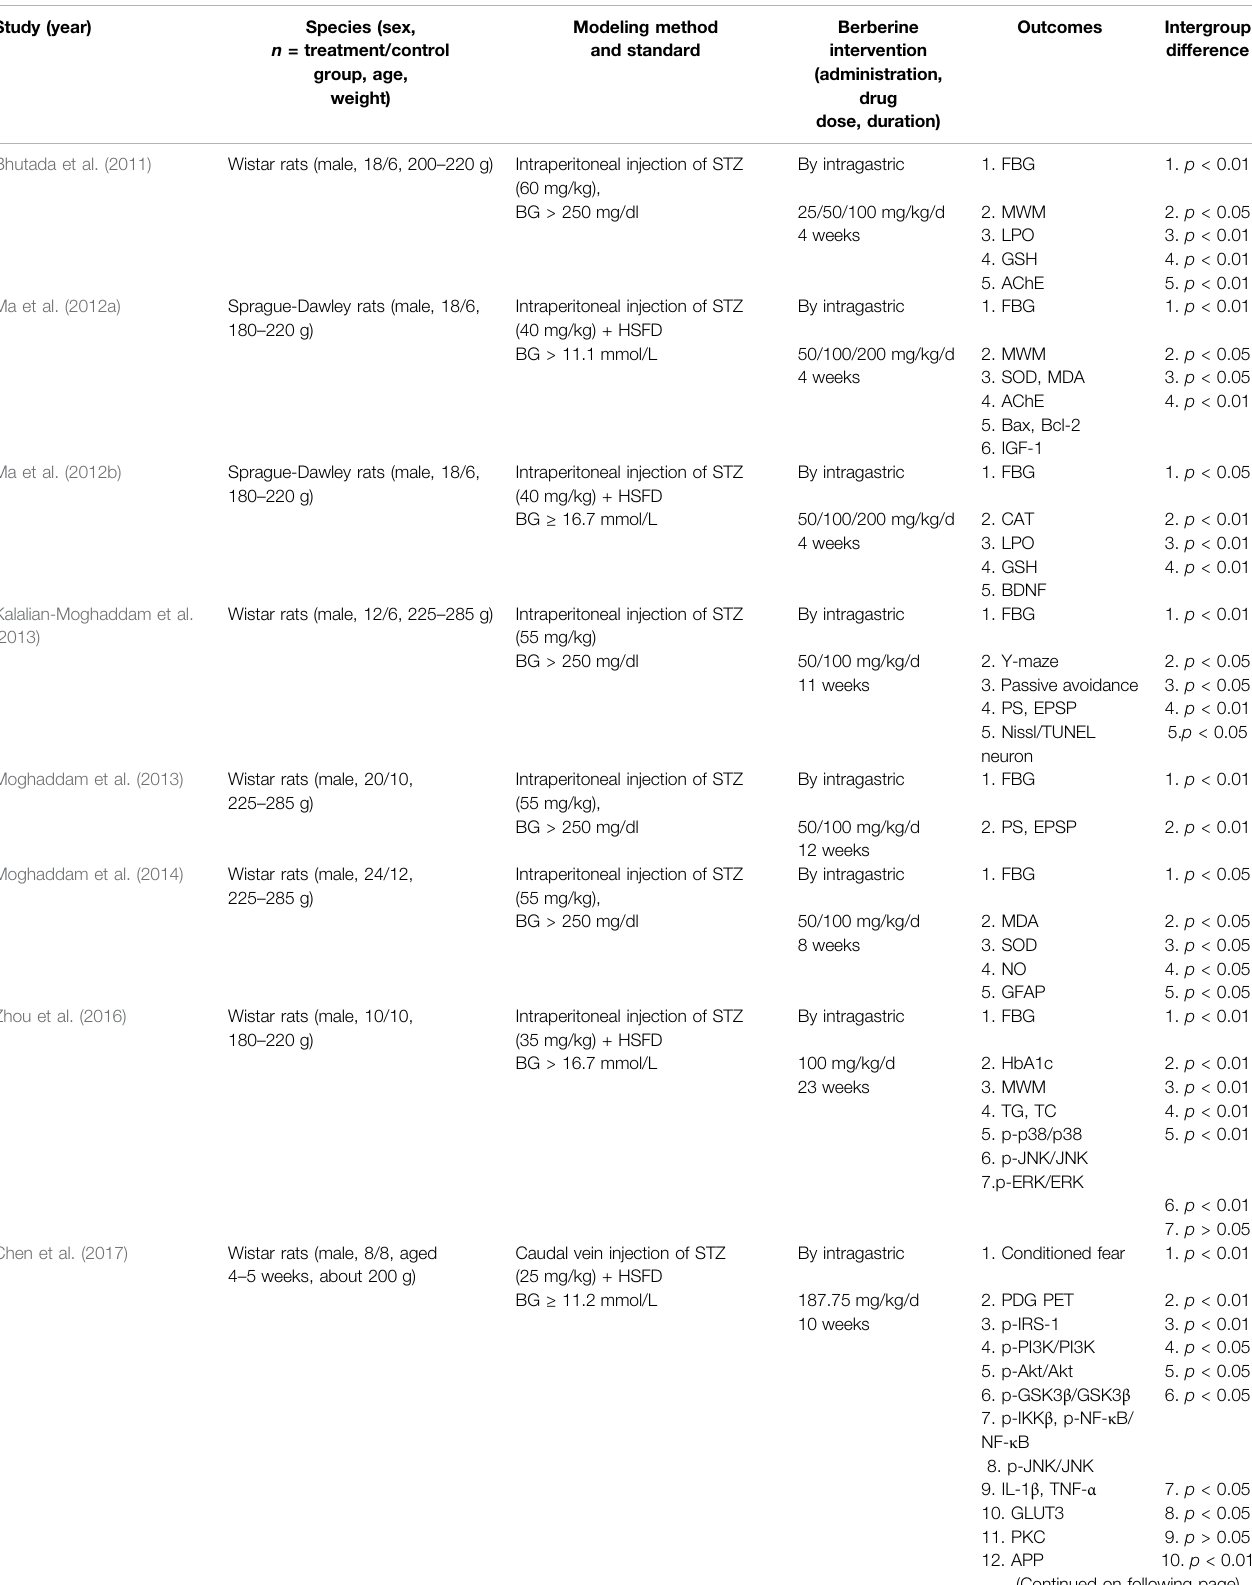
TABLE 2 | Basic characteristics of the 20 included